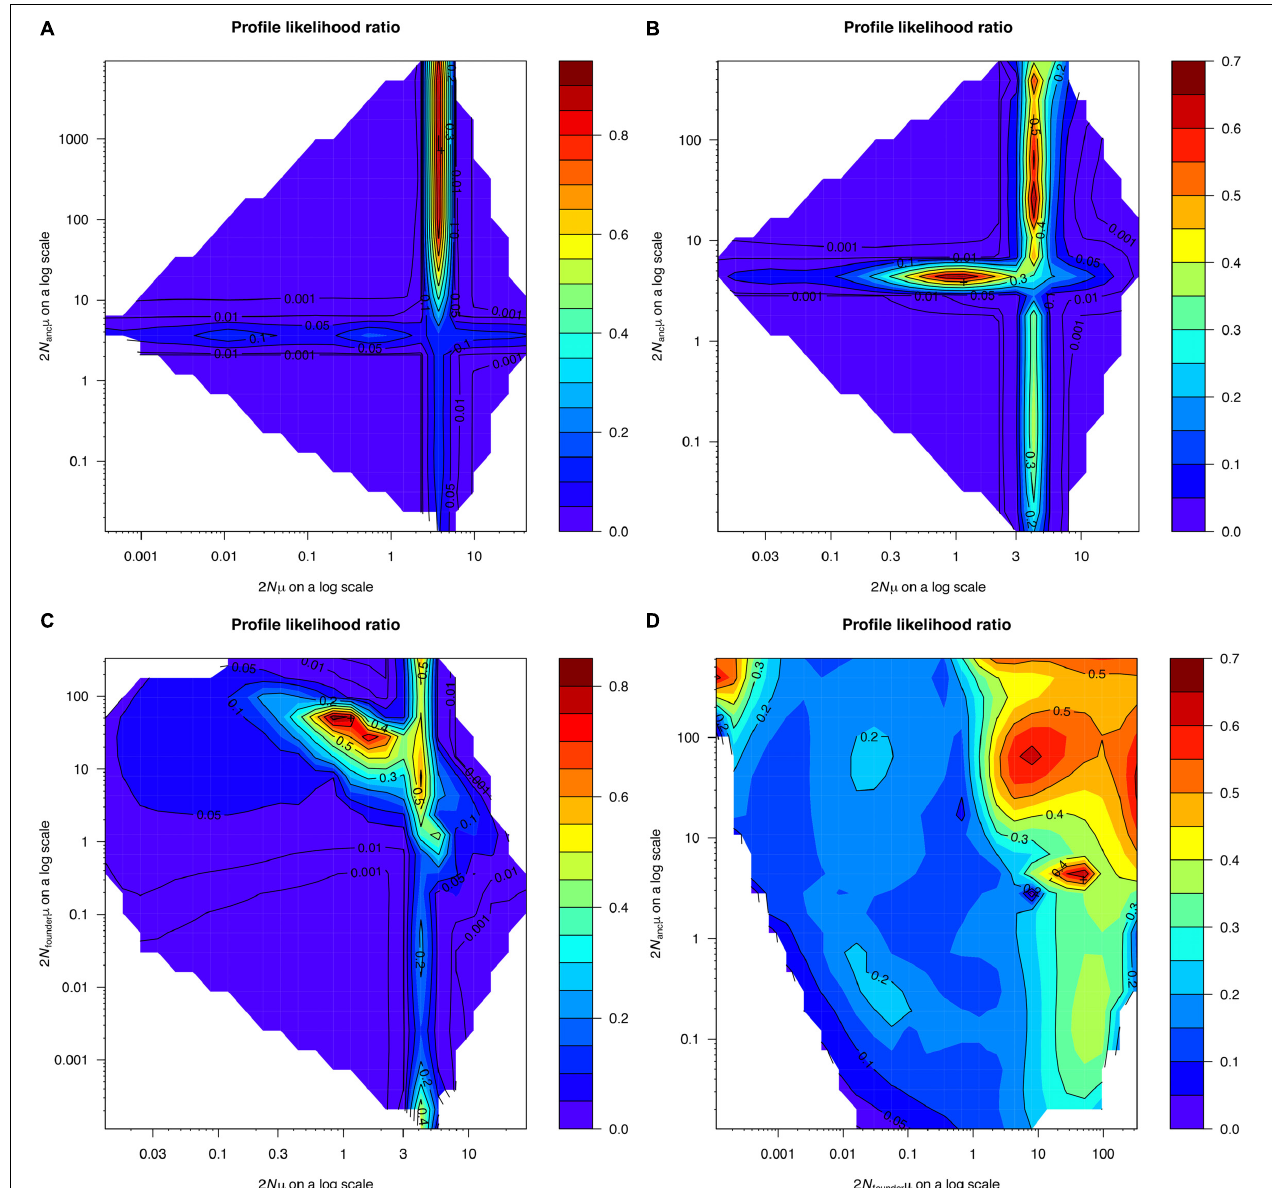
FIGURE 8 | Profile likelihood ratio of the current population size of Dendrogyra cylindrus ( x -axis) and the ancestral population size of D. cylindrus ( y -axis) from the OnePopVarSize model implemented using the software MIGRAINE (A) . Profile likelihood ratio plots for the OnePopFounderFlush model are shown for the current and ancestral populations (B) , for the current and founder populations (C) , and for the founder and ancestral populations (D) .